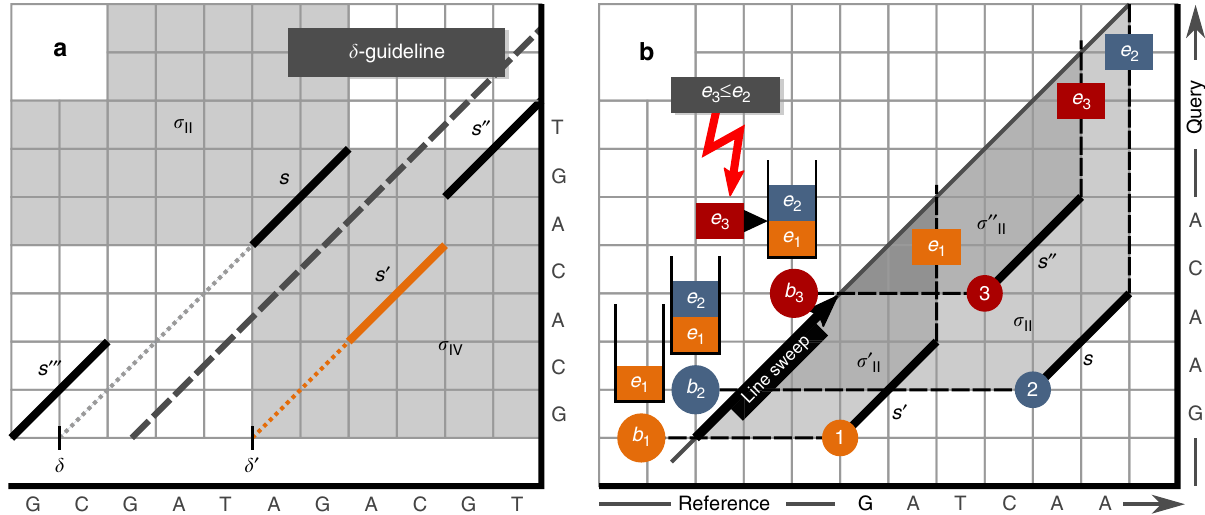
Fig. 7 Seed-Shadows. a We consider a SoC with 4 seeds. The shadows spawned by the seed s are displayed. The dashed line visualizes the guideline used in the context of the removal of con fl icting seeds. S A = { s , s ′′ , s ′′′ } and S B = { s ′ , s ′′ , s ′′′ } represent sets of mutually consistent seeds. s and s ′ shadow